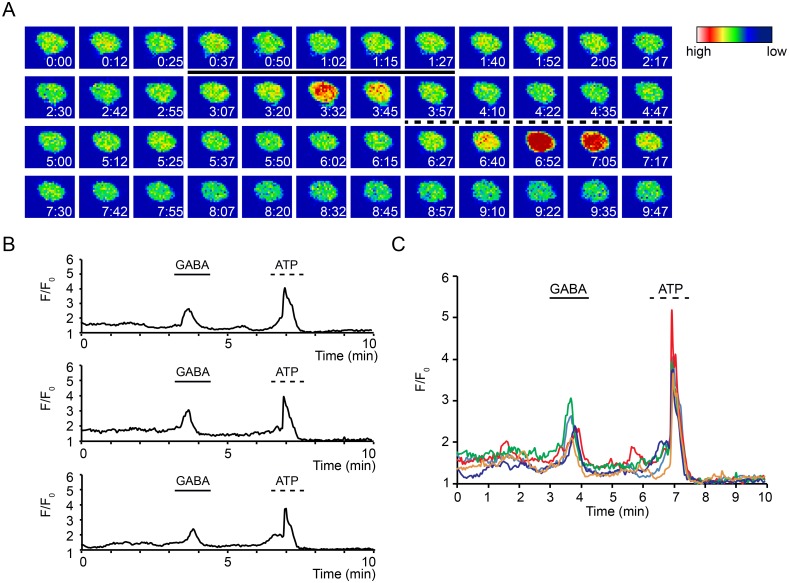
GABA elicits Ca2+ influx transients in DCs.(A) Representative pseudocolor micrographs of live cell Ca2+ imaging of DCs loaded with 2 μM Fluo-8H/AM as described in Materials and Methods. Continuous line indicates perfusion time of GABA (10 mM) and dashed line indicates perfusion time of ATP (50 μM). For each micrograph color scale indicate fluorescence intensity at indicated time point (min:sec). (B) Relative fluorescence intensity of DCs as in (A). The lines indicate perfusions of GABA (10 mM) after 3 min and ATP (50 μM) after 6.5 min, respectively. Displayed data are 3 representative traces from one experiment. (C) Relative fluorescence intensity of DCs as in (A) and (B). Displayed data are 5 superposed representative traces from the same experiment. Experiments were performed 3 times with similar results (n = 15–20 cells per experiment).